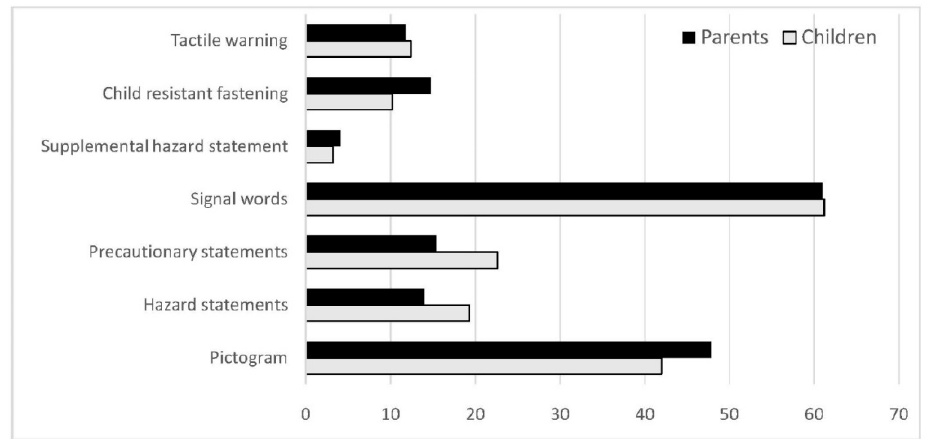
Figure 3. Perception (%) by the users of hazard communication on the packaging/label.